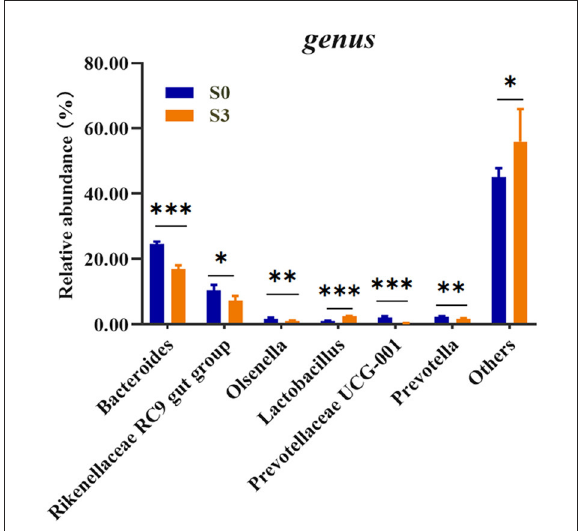
FIGURE1 Comparison of relative abundances of significantly different microbial taxa at the genus levels between S0 and S3. S0, blank control group, broilers were fed diet without BMFA supplementation; S3, broilers were fed diet supplemented with 0.6% of BMFA. The asterisk (*) indicates P < 0.05, (**) indicates P < 0.01, and (***) indicates P < 0.001, n = 5.